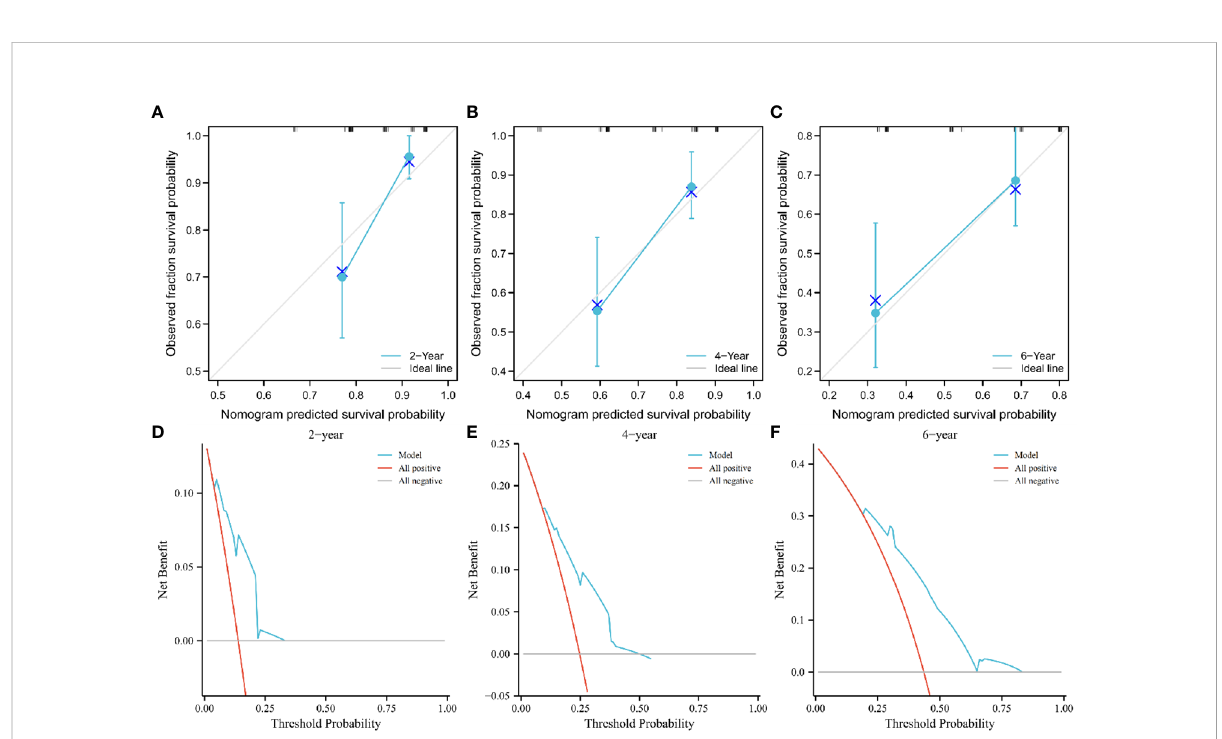
FIGURE 5 Calibration curve showing good fi t between the predicted nomogram curve and the observed curve (A – C) . DCA of the nomogram at 2, 4, and 6 years. The green and gray line indicates that all patients were dead or alive, respectively. The red line indicates the clinical net bene fi t of the nomogram at different threshold probabilities (D – F) . DCA, decision curve